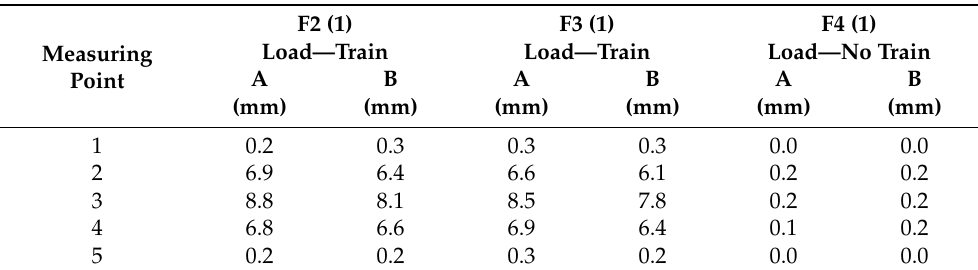
Table 3. Static load test results of the steel railway bridge Kloštar over the river Dobra